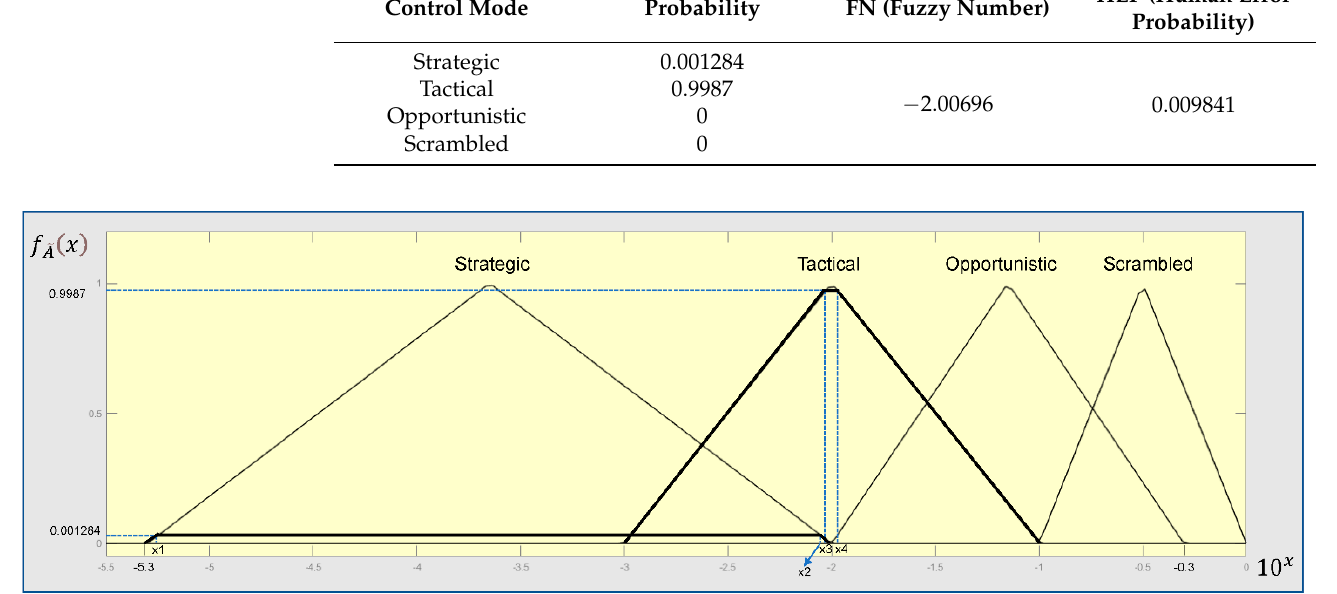
Figure 10. The degrees of the fuzzy membership functions of COCOMs (x1= − 5.29788; x2= − 2.0021186; x3= − 2.0013; x4= − 1.9987). Table 10. The probabilities of the COCOMs and the human error probability